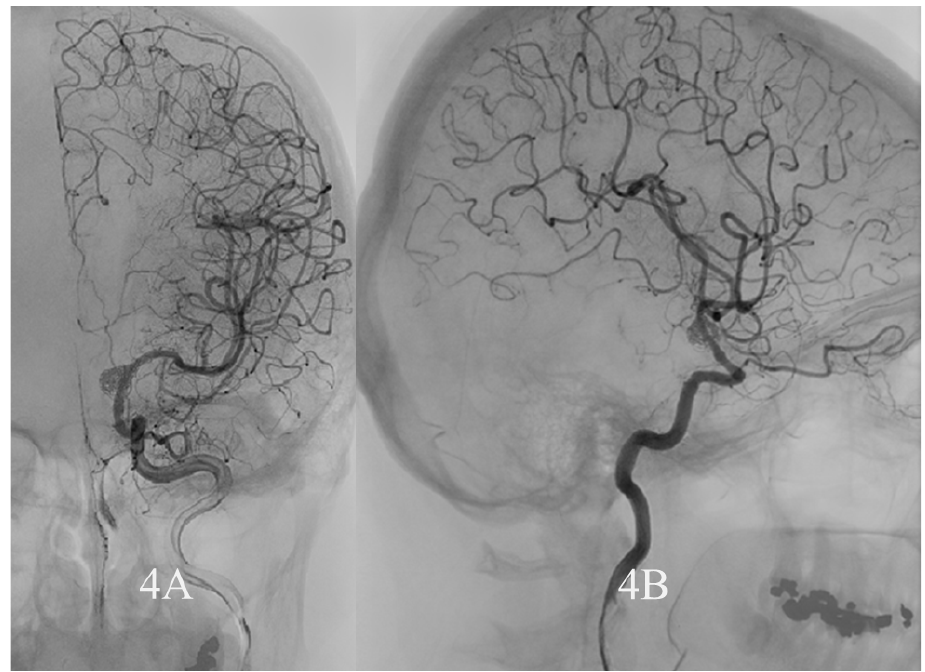
Fig. 4A,B. The digital subtraction angiogram in lateral and anteroposterior view 7 months later proved complete remodelling of the ICA. The patient made a full